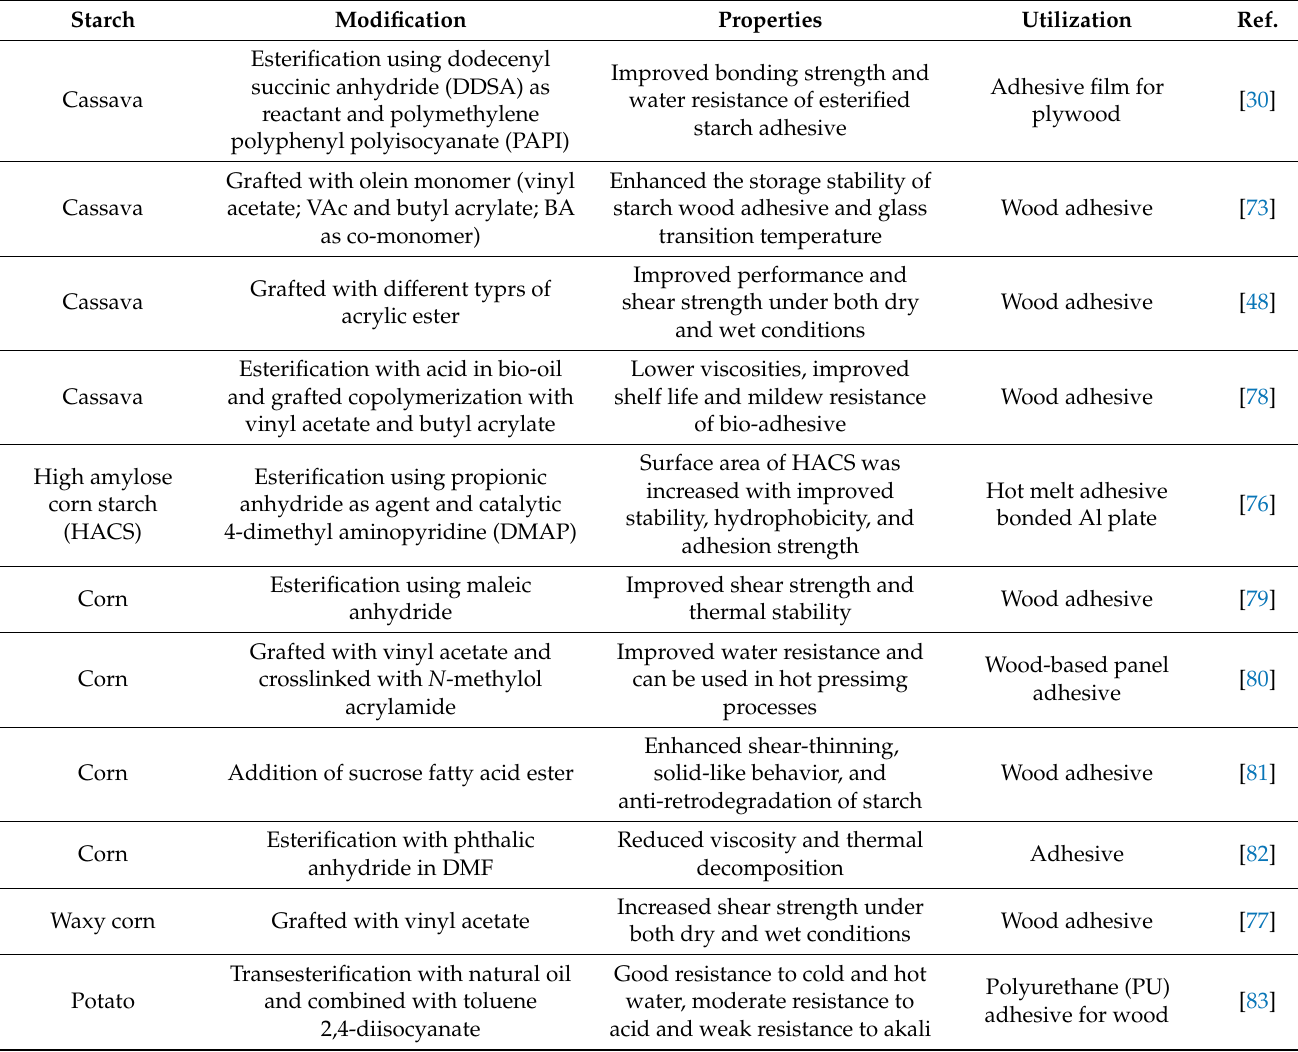
Table 3. Esterified starch derived adhesives. The properties are reported relatively to those of corresponding native